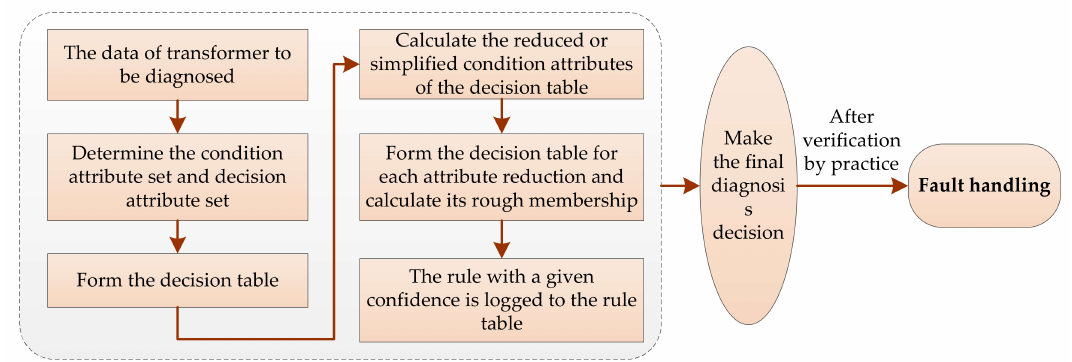
Figure 4. The flow of fault diagnosis based on the RST presented in